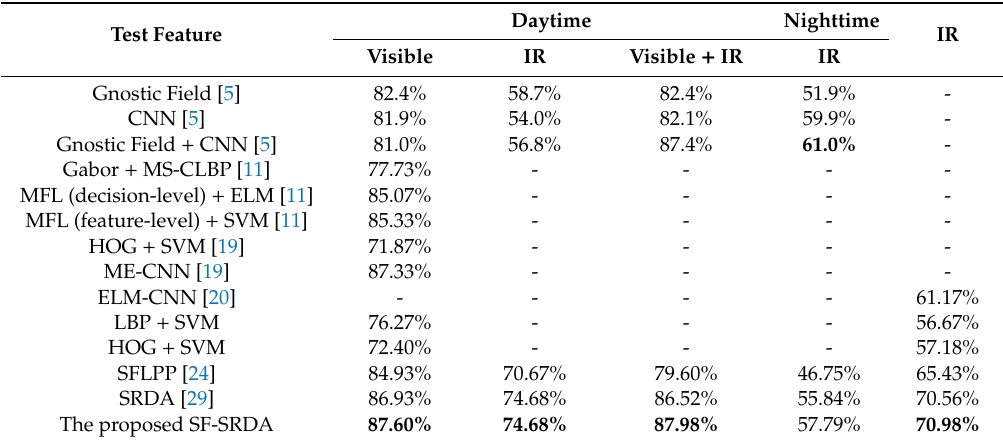
Table 5. Coarse-grained results among SF-SRDA and the